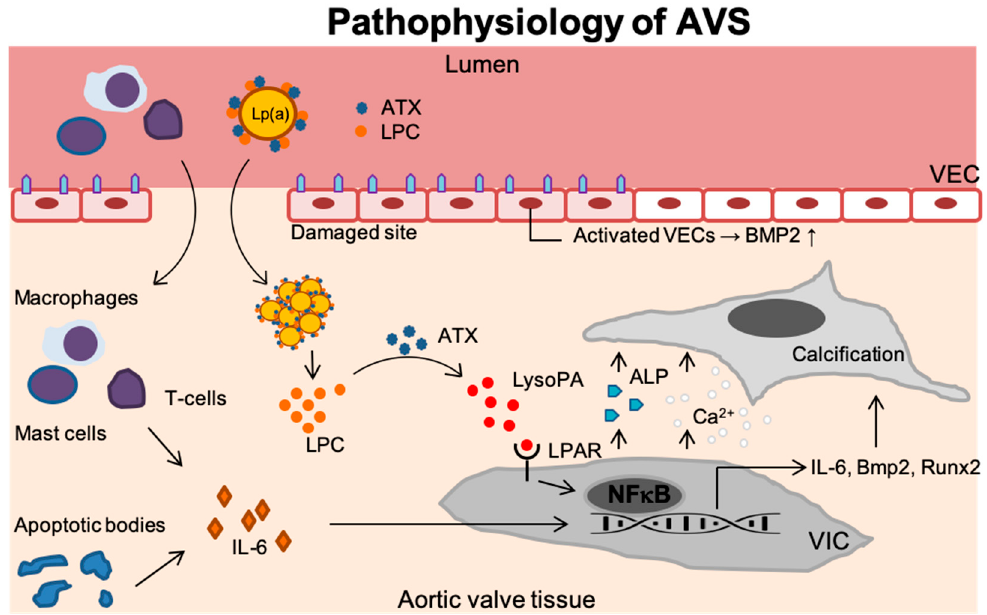
Figure 1. Disease progression in AVS. Upon endothelial damage, an inflammatory environment arises once immune cells (i.e., T-lymphocytes, mast cells and macrophages) enter the valvular tissue and secrete IL-6. In addition, endothelial damage leads activation of VECs which thereby produce BMP2 but also the formation of apoptotic bodies further contributes to inflammation. Lp(a) carrying ATX and LPC accumulates in the valves. ATX then converts LPC into LysoPA which binds the LPAR leading to activation of NF- κ B. The activated VICs now increase the IL6 , BMP2 , and RUNX2 transcripts but secrete ALP as well. This leads to increased calcium deposition and calcification of the aortic valve tissue. Lp(a): Lipoprotein(a); ATX: Autotaxin; LPC: Lysophosphatidylcholine; VEC: Valvular endothelial cell; IL-6: Interleukin 6; LysoPA: Lysophosphatidic acid; LPAR: Lysophosphatidic acid receptor; VIC: Valvular interstitial cell; NF- κ B,: Nuclear factor - κ B; Runx2: Runt-related transcription factor 2; BMP-2: Bone morphogenetic protein-2; Ca 2 + : Calcium; ALP: Alkaline phosphatase.